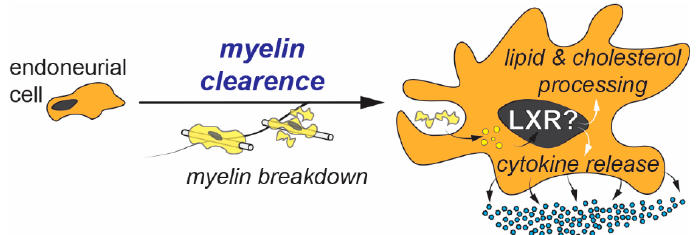
Figure 3. Role of Endoneurial cells in myelin clearance after injury. In response to myelin breakdown, endoneurial cells digest myelin debris through phagocytosis and release cytokines to create a proinflammatory environment. Given the capacity of LXRs to regulate lipid / cholesterol metabolism and immune responses, LXR signaling might play an important role in the physiology of these